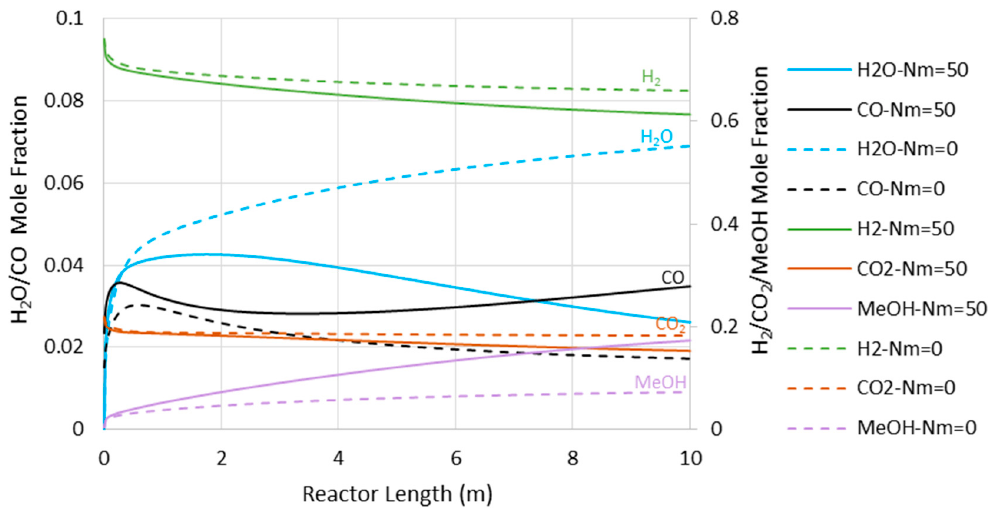
Figure 9. Species’ concentration profiles through the isothermal reactor length at 7500 kPa (Nm = 0 corresponds to CR).